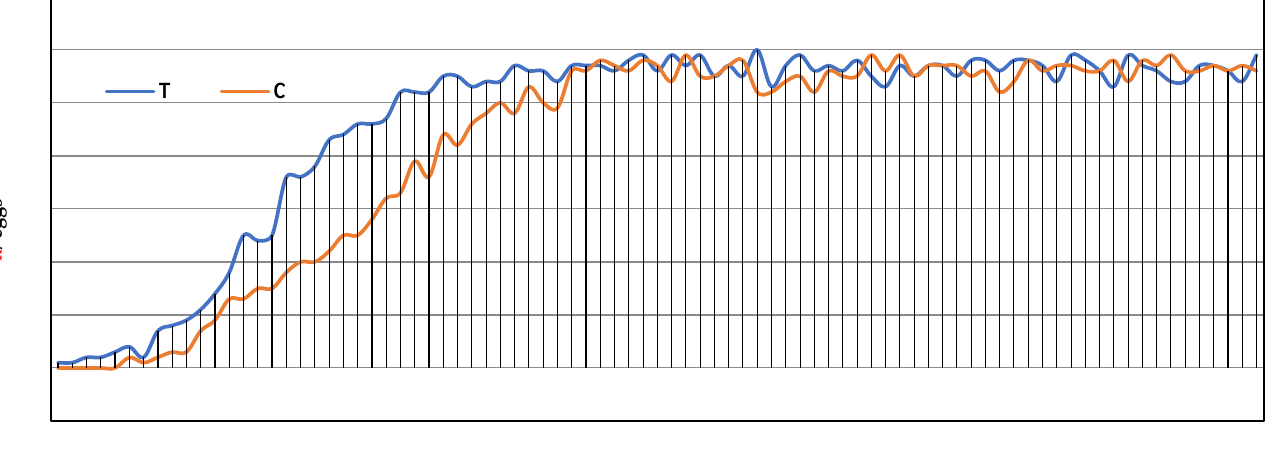
Figure 1. Egg production curve for a total of 12 weeks of laying, corresponding to the 7th to 19th week of the trial, expressed as day of laying. T = supplemented hens ( n = 60); C = control hens ( n = 60).